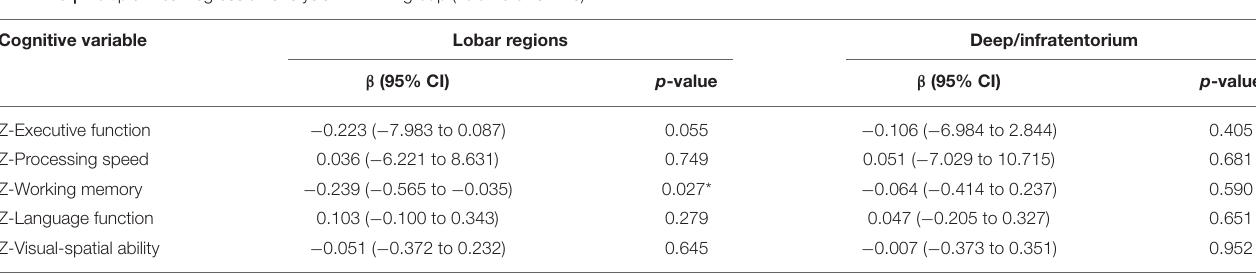
TABLE 5 | Multiple linear regression analysis in T2DM group (volume of CMBs).